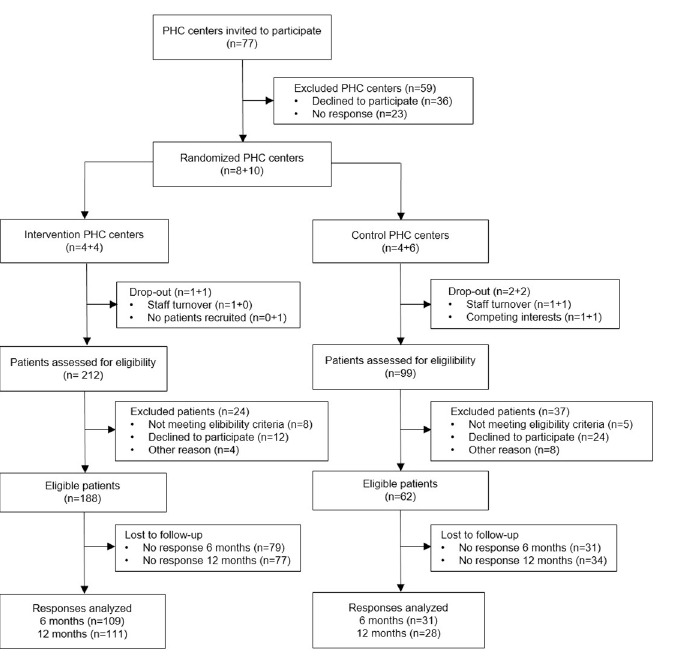
Fig 1. CONSORT flow